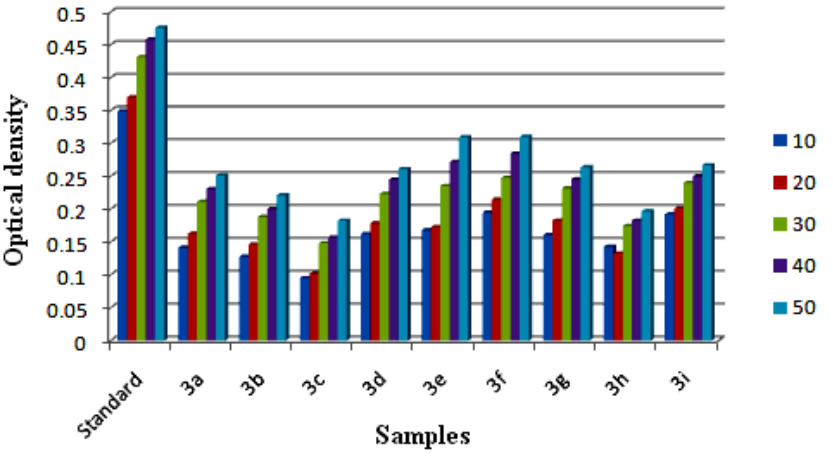
Figure 14. Ferric ion reducing power ability of samples 3 ( a – i ) at different concentration (10–50 μ g/mL) measured at 700 nm. Values are expressed as absorbance; high absorbance indicates high reducing power.